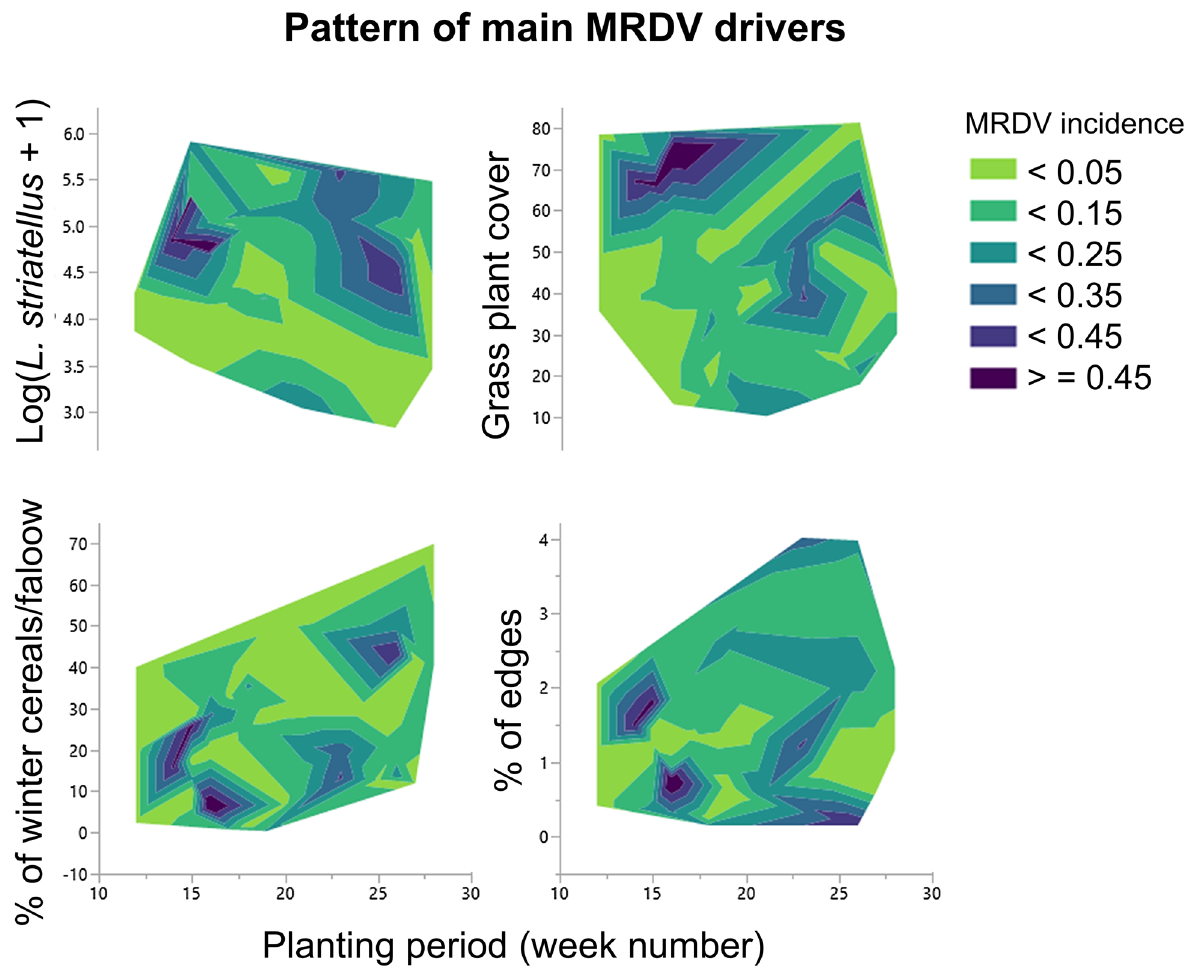
Figure 3. Pattern of the main MRDV drivers. The contour plot contains the following elements: predictors on the X axis (planting period) and Y axis (abundance of L. striatellus , proportion of winter cereal/fallow, proportion of edges in the landscape and percentage of grass cover plants at the edges). Contour lines connect points that have the same adjusted response non-propagative maize viruses such as maize dwarf mosaic virus (MDMV), the closeness of maize field edges also had a strong effect, measured on a spatial scale of 200 m in the maize fields sampled 40 . Moreover, in the early season, grasses could provide the resources needed by the vector for overwintering, while in the late season, grasses in the ground cover of irrigated orchards could remain greener than those at the edges and could be a suitable host for vector reproduction in this area, as remarked by Clemente-Orta et al . 41 . Specifically, the ground cover in the orchard was characterized by a higher level of H. murinum and C. dactylon, and these species could act as potential virus and vector resources 20 . Then, later in the season, when summer is approaching, the young